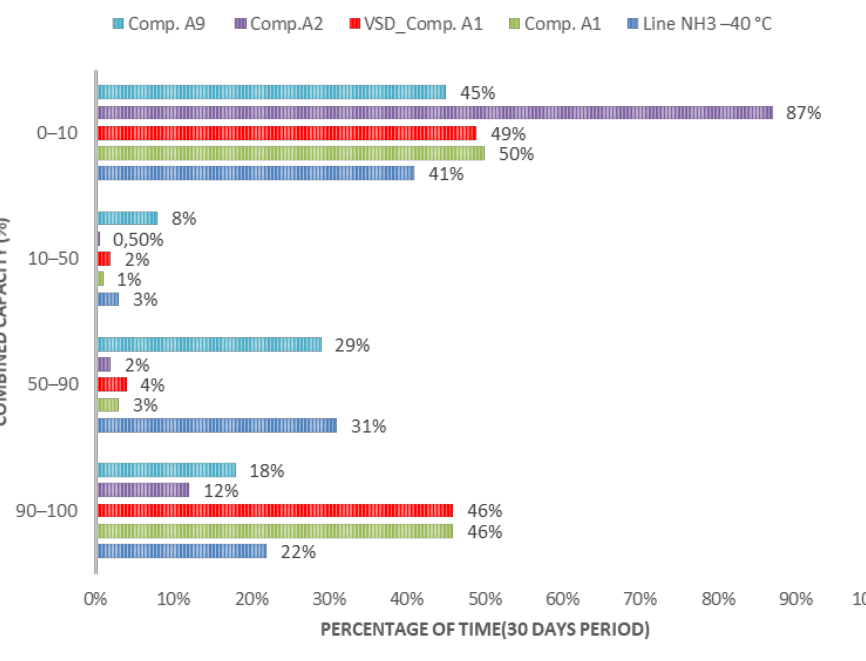
Figure 9. Capacity analysis for the − 40 ◦ C circuit.